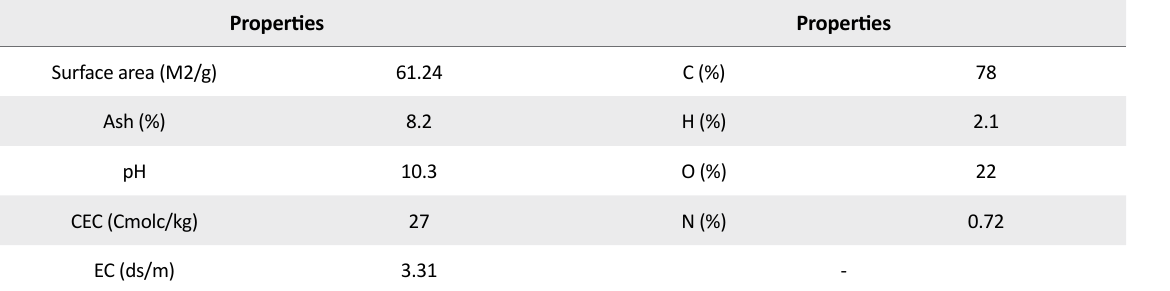
Table 3. Properties of CW biochar Properties